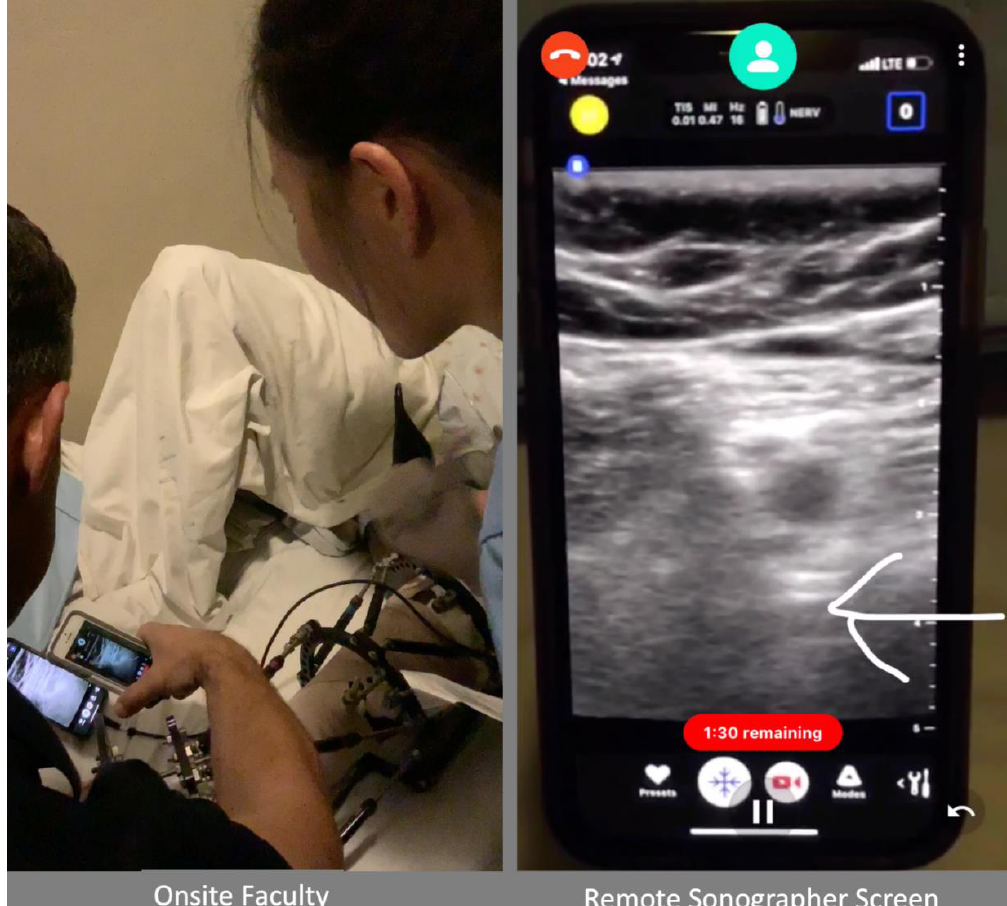
Figure 1. Overview of Onsite and Remote Augmented Reality Enhanced Video Communication. The white arrow indicates the femur, which was identified for anatomy review during remote guidance communication.